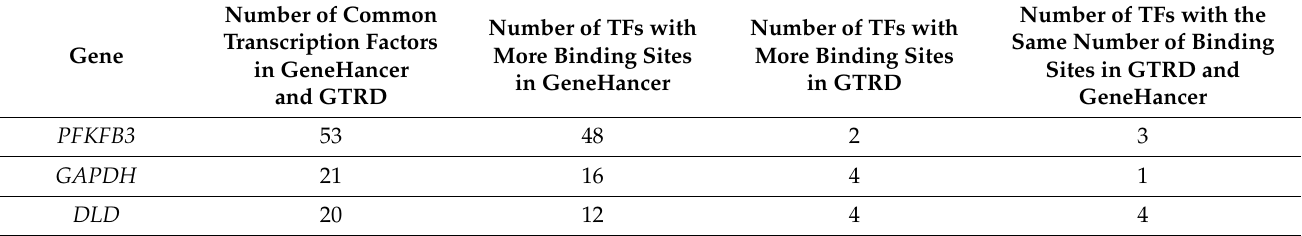
Figure 3. Number of transcription factor binding sites for transcription factors that interact with PFKFB3 , DLD or GAPDH , as annotated by GTRD and GeneHancer. Grey bars represent the number of TF binding sites in the interval − 1000 to +100 around the transcription start site of the target gene according to GTRD. Yellow bars represent the number of TF binding sites outside the interval − 1000 to +100 around the transcription start site of the target gene according to GeneHancer. ( A ) The transcription factors binding sites for PFKFB3 , ( B ) The binding sites for DLD , ( C ) The binding sites for GAPDH . Table 17. Number of binding sites in GTRD and GeneHancer for PFKFB3 , DLD and GAPDH in untreated RA CD8 + Tem cell differential co-expression